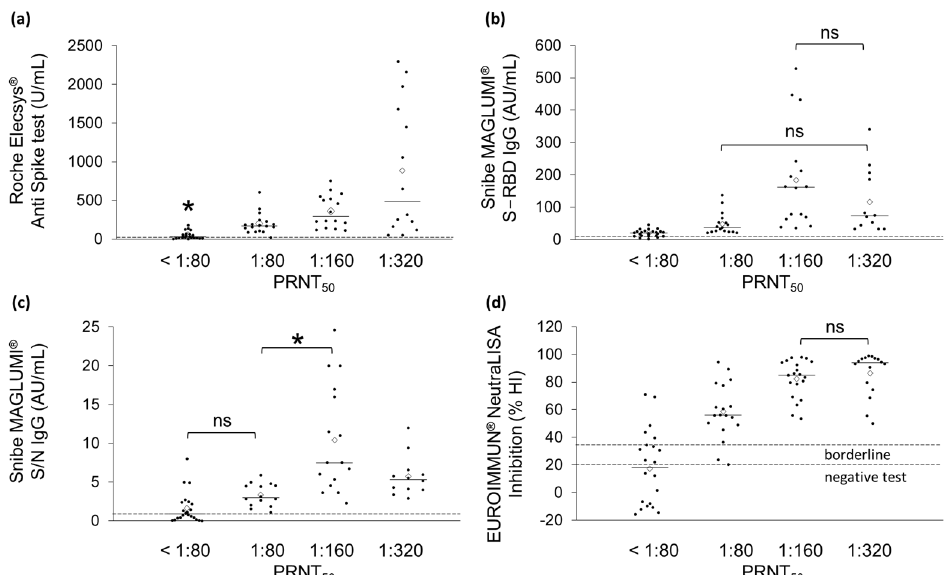
Figure 1. Scatter plots showing the results of the four serological tests, grouped according to PRNT 50 NAb titers. Solid lines represent median values, white rhombi mean values. ( a ) Roche Elecsys ® Anti Spike test (cut off ≥ 0.80 U/mL), ( b ) Snibe MAGLUMI ® S-RBD IgG test (cut off ≥ 1.00 AU/mL), ( c ) Snibe MAGLUMI ® S/N IgG test (cut off ≥ 1.00 AU/mL), ( d ) EUROIMMUN ® NeutraLISA assay (cut off <20% for negative test and up to 35% for borderline values). Dotted lines represent the cut-off for each test. Statistically significant differences between NAb titer groups were assessed by one-way ANOVA and Bonferroni correction (* p < 0.05. ns: not significant).